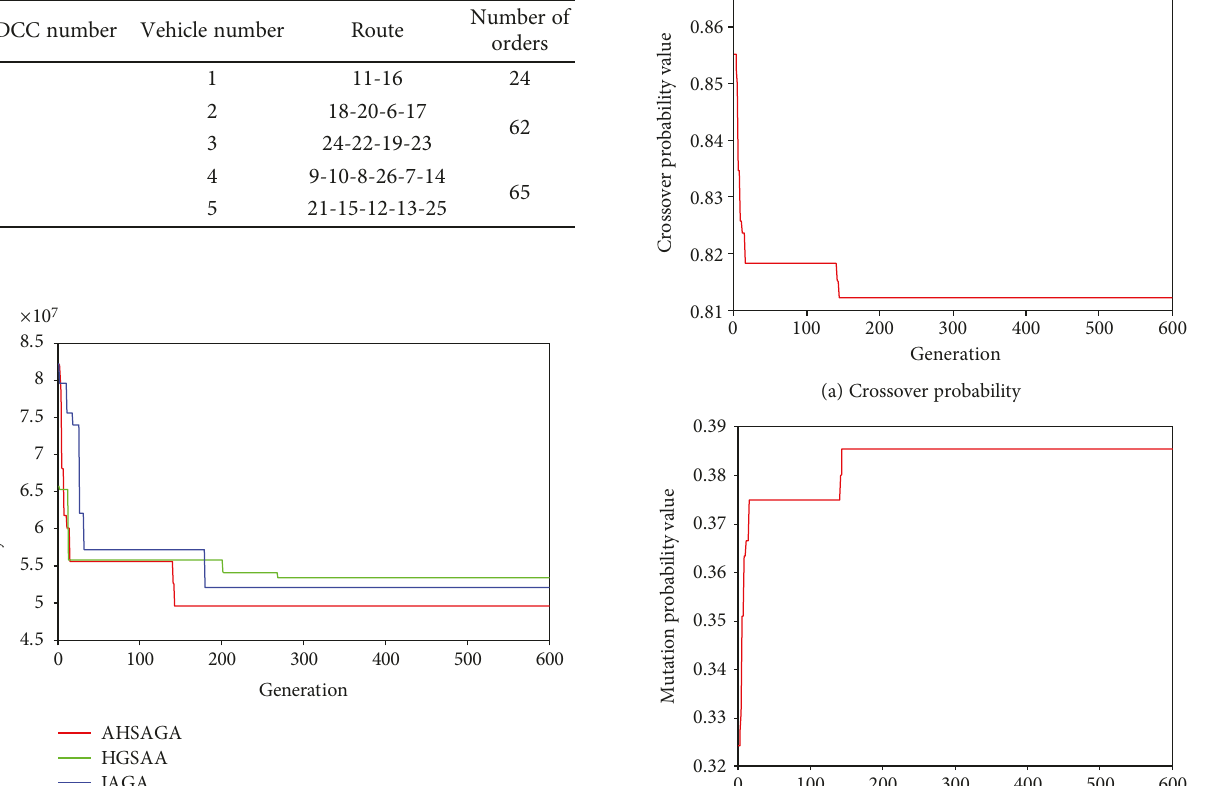
Figure 4: Trend in objective values.